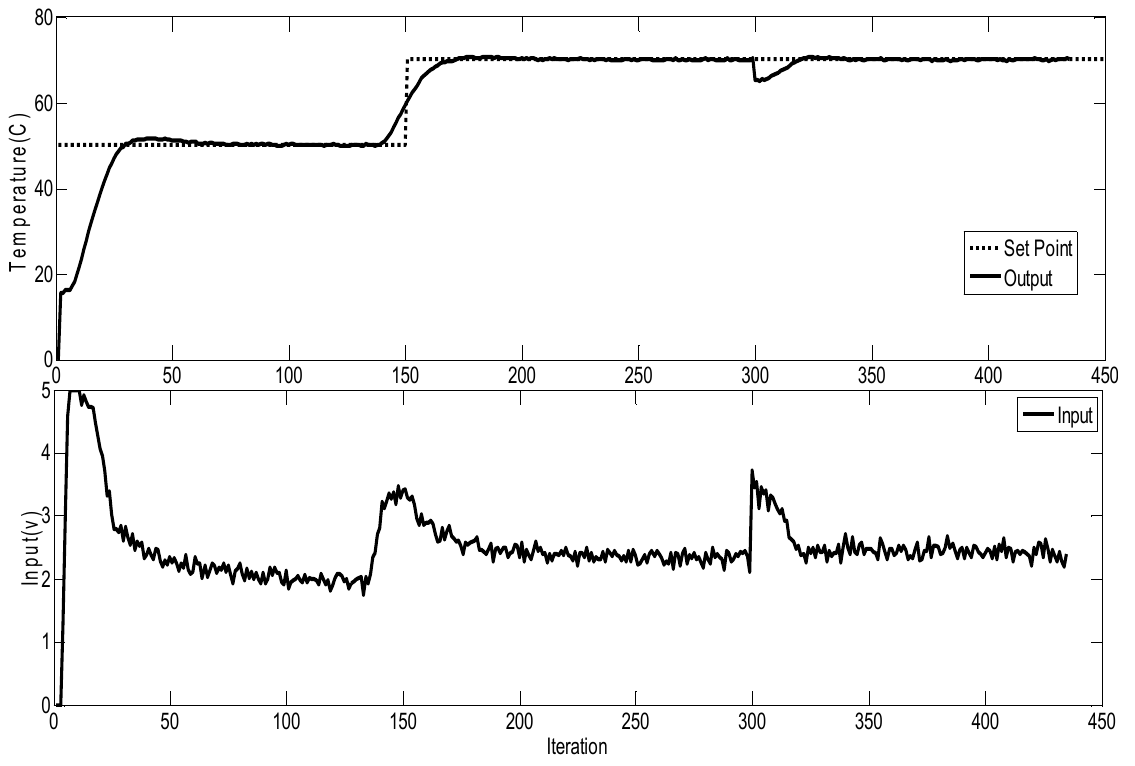
Figure 8. RFPC-GGP controller based on STM32 microcontroller.